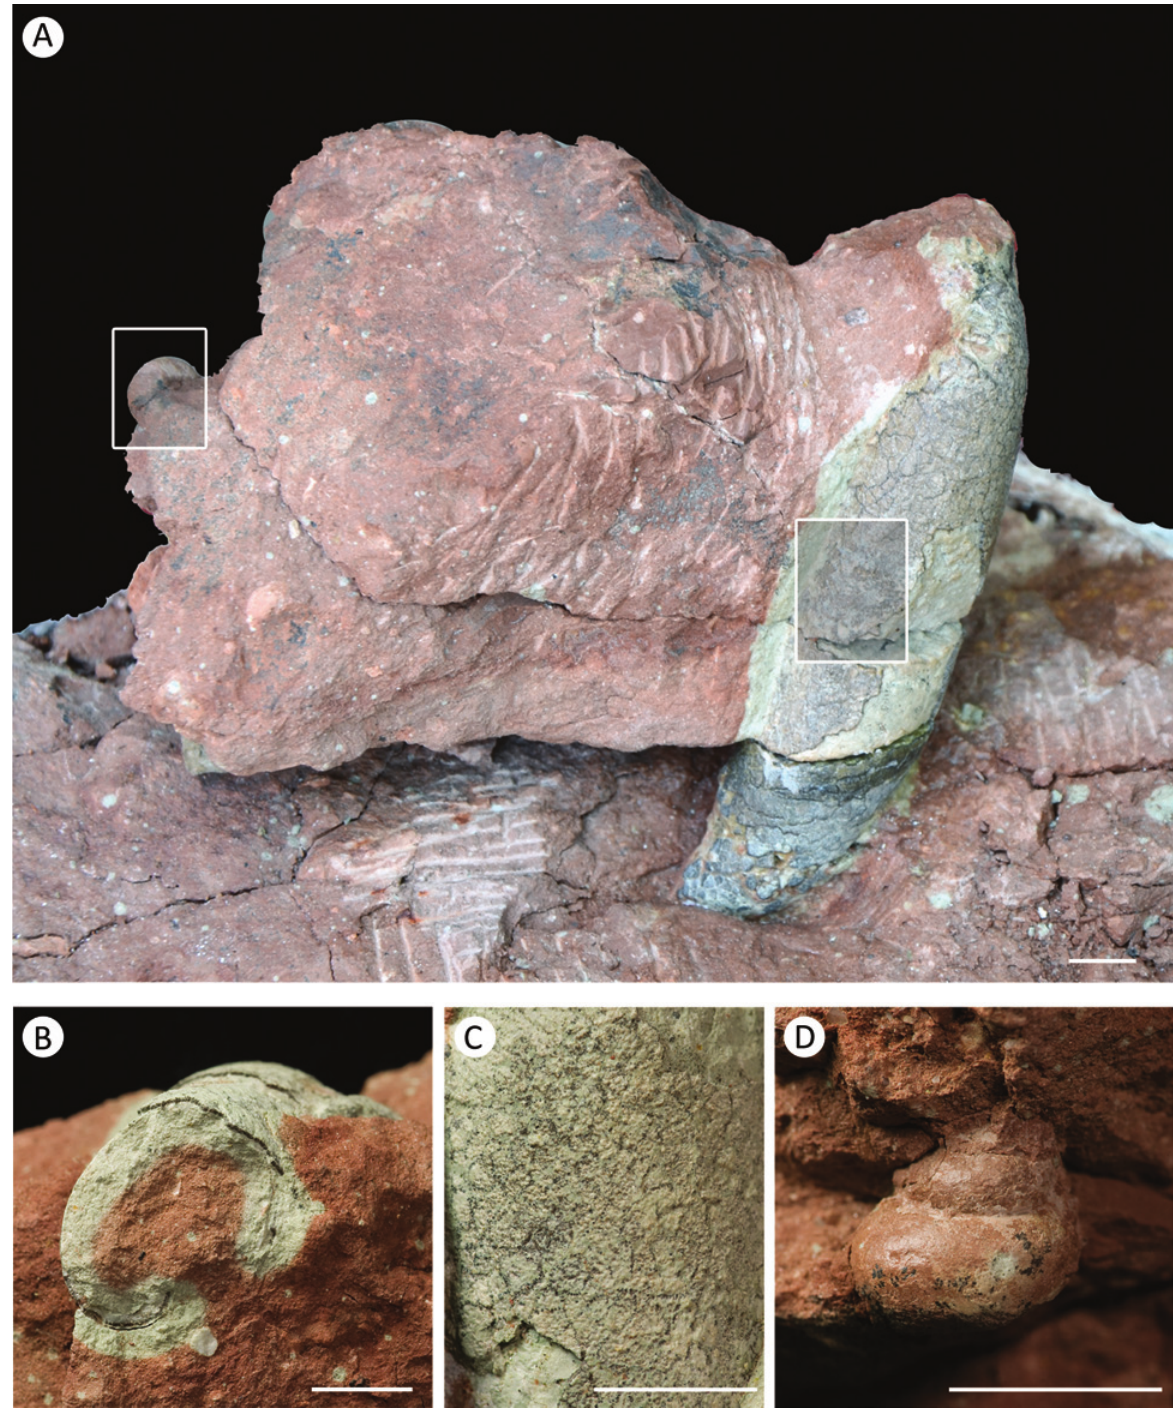
Fig. 3 - Holotype of Emydoolithus laiyangensis oogen. et oosp. nov. A. the whole fossil specimen (IVPP V18544), showing the egg and a gastropod (in the white frame); B. top view of the egg, showing the interior filled by muddy siltstone; C. enlarged part of the egg (the white frame in A) showing small pieces of eggshell; D. the gastropod near the egg (the one in the white frame in A) Scale bars=1